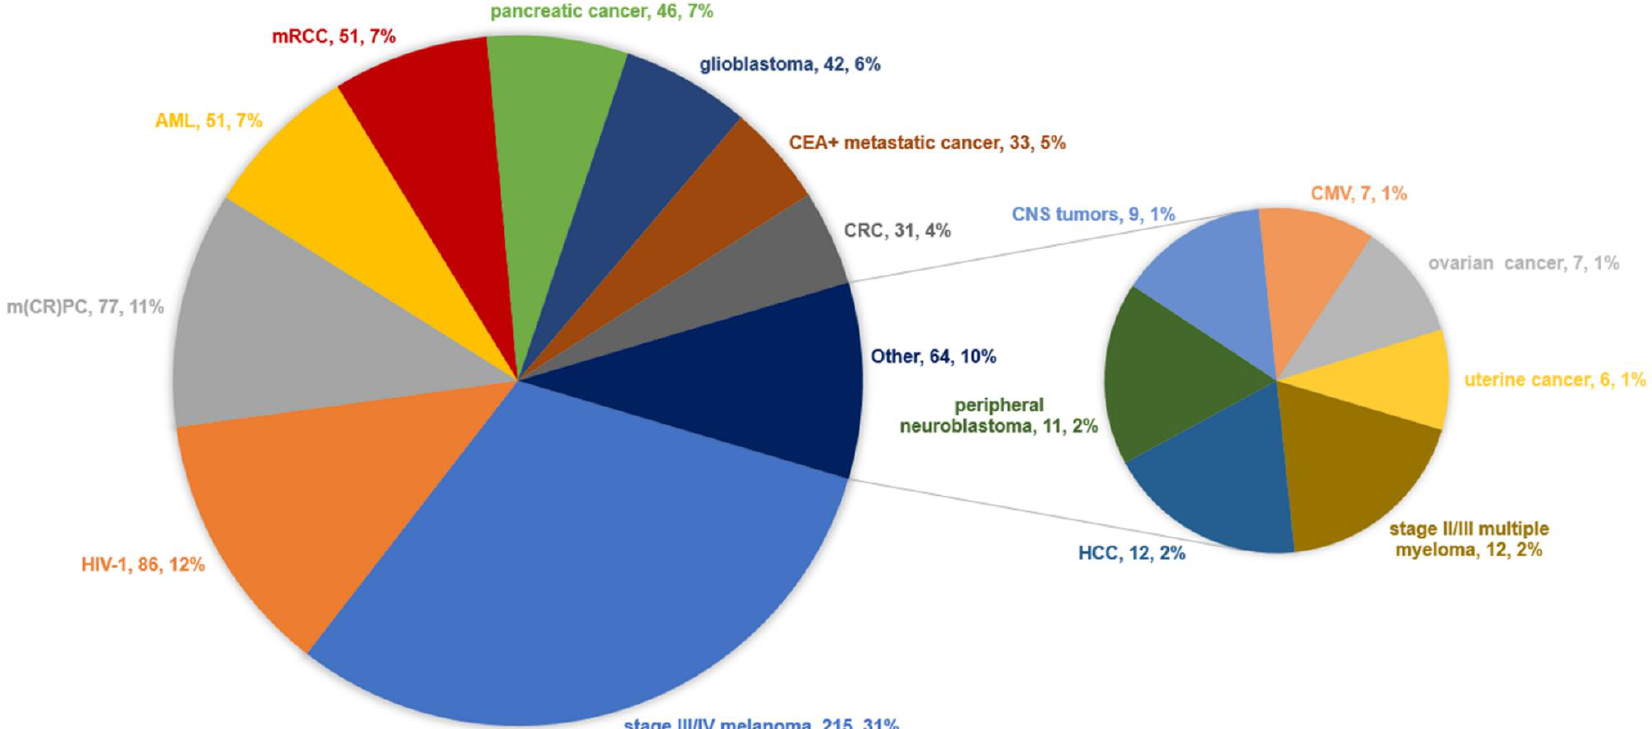
Figure 1. Distribution of all patients vaccinated in clinical trials with RNA-modified dendritic cells per disease setting, including the number and percentage of total ( n = 696). Abbreviations: AML, acute myeloid leukemia; CEA, carcinoembryonic antigen; CMV, cytomegalovirus; CNS, central nervous system; CRC, colorectal cancer; HCC, hepatocellular carcinoma; HIV-1, human immunodeficiency virus-1; m(CR)PC, metastatic (castration-resistant) prostate cancer; mRCC, metastatic renal cell carcinoma; RNA, ribonucleic acid.